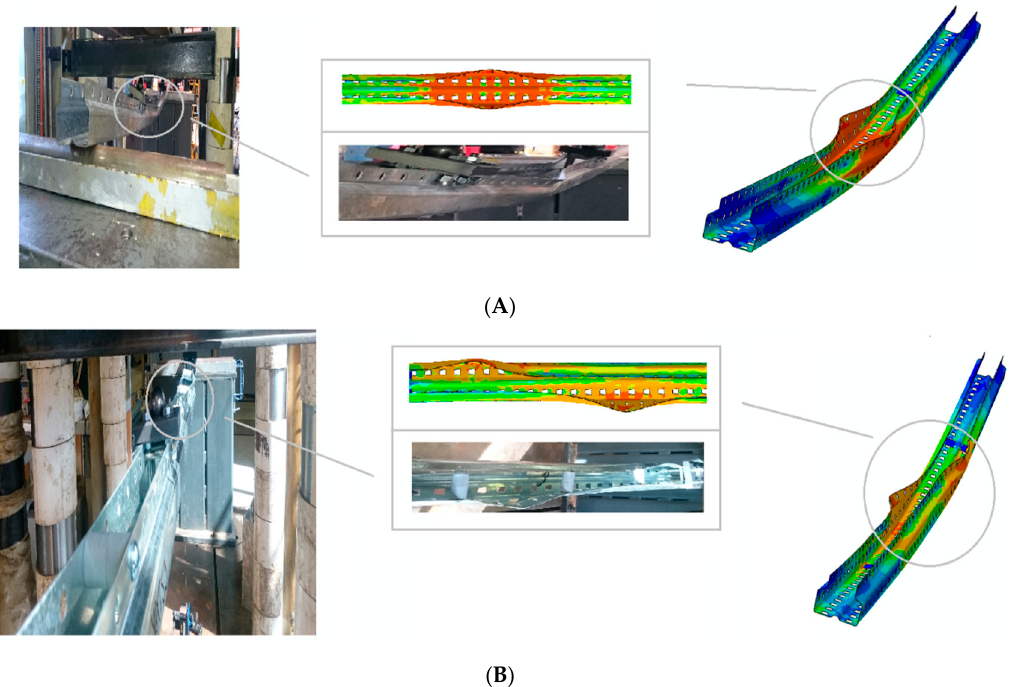
Figure 27. Comparison of failure modes: ( A ) non-reinforced upright type; ( B ) 300 mm reinforced upright type.